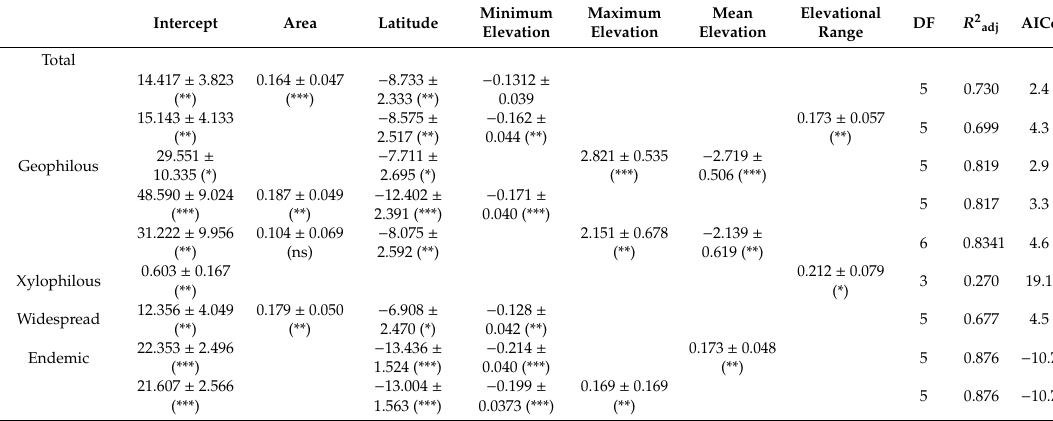
Table 3. Best-fit models for the influence of area, latitude, and elevation on tenebrionid richness in Italian reserves. DF: degrees of freedom, R 2adj : adjusted R 2 , AICc: corrected Akaike Information